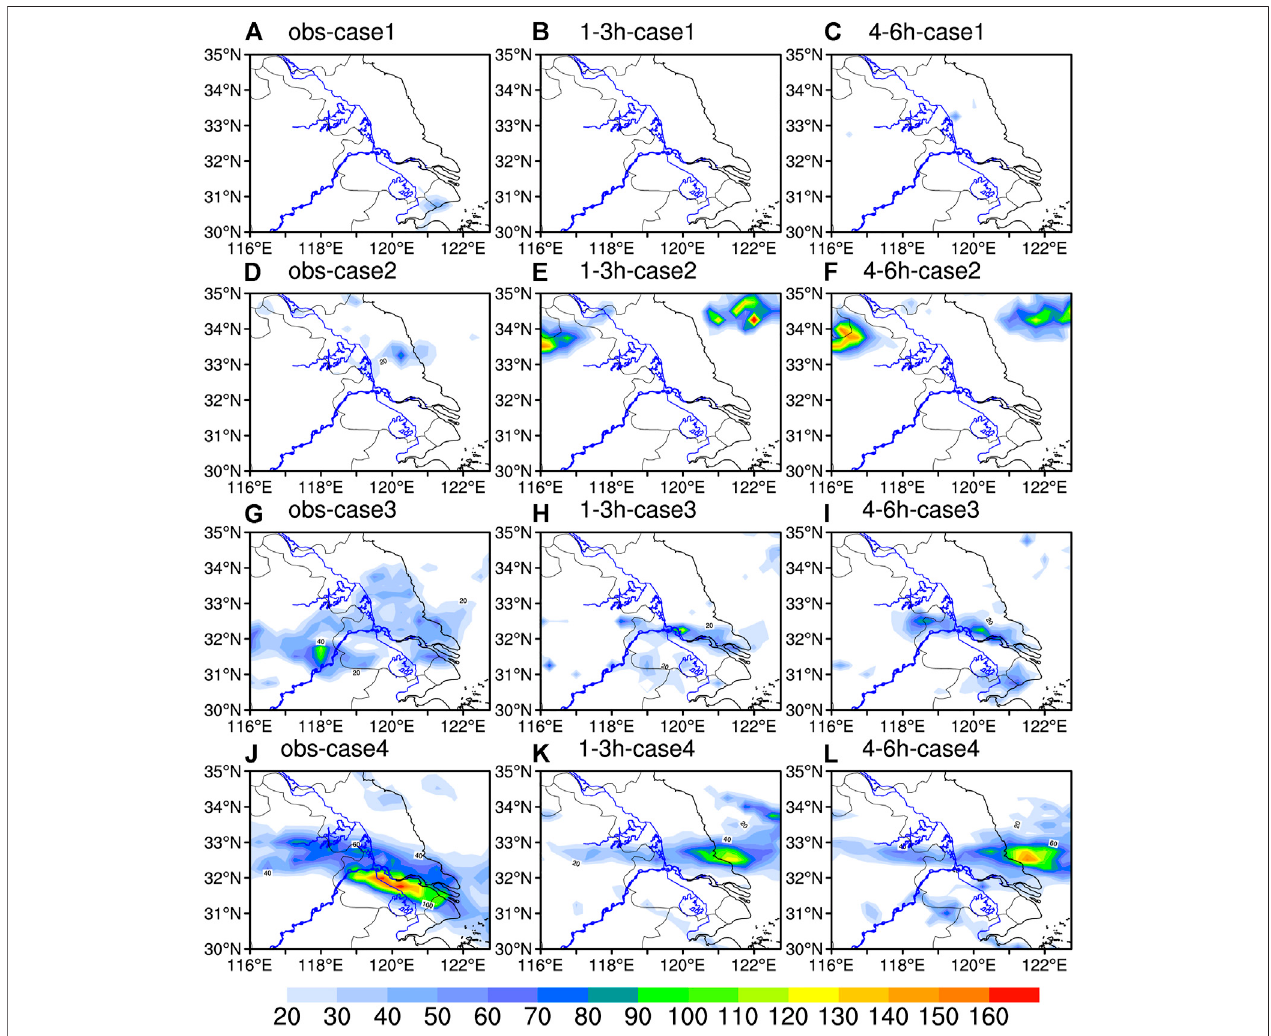
FIGURE 4 | Spatial distributions of accumulated precipitation ( mm ) during WRWS cases in observations (A,D,G,J) and the PWAFS forecasts with different lead times: 1 – 3 h (B,E,H,K) and 4 – 6 h (C,F,I,L) .